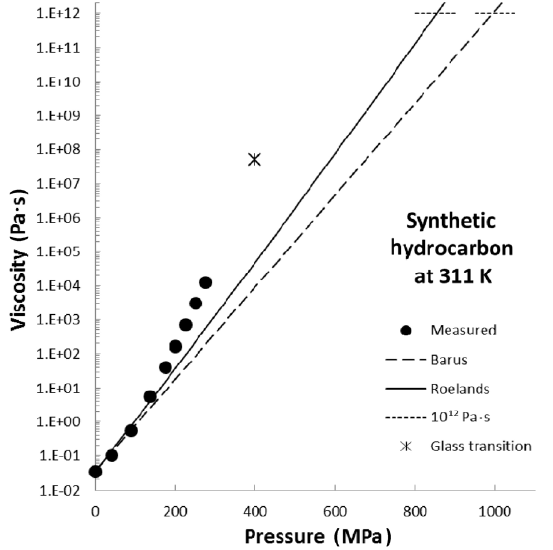
Fig. 6 The Barus and Roelands extrapolations of Hamrock et al. [13] compared with the measurements and showing the glass transition